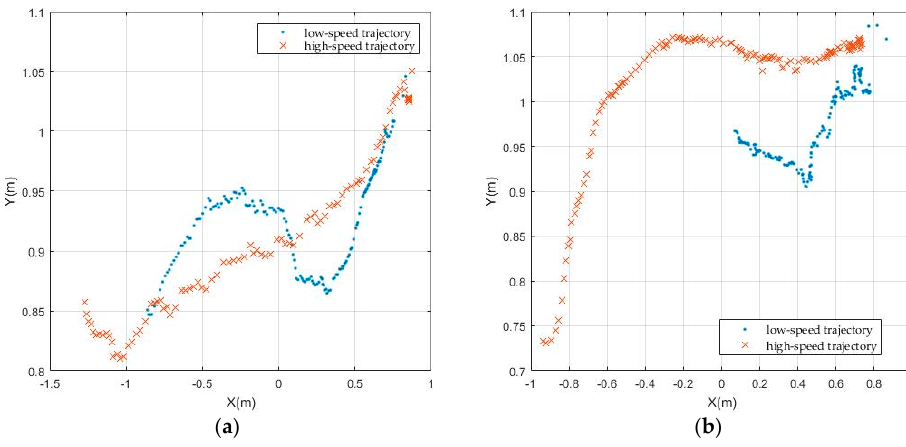
Figure 15. The tracking results at different moving speeds: ( a ) Results with KF; ( b ) Results with adaptive PF. adaptive